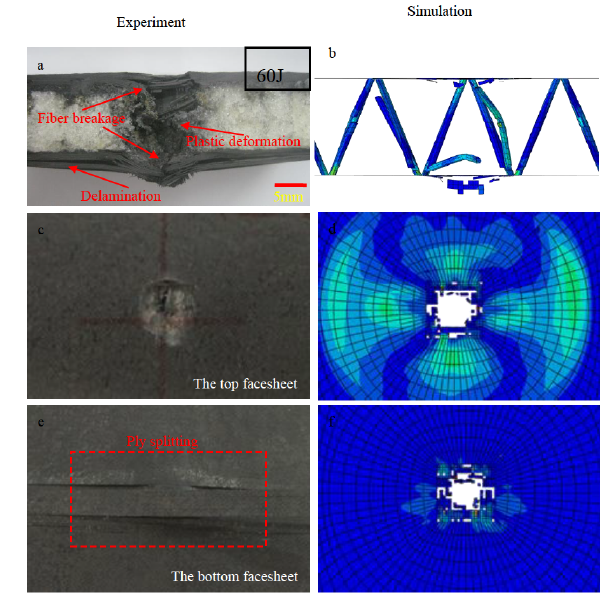
Figure 16: Impact damage of experimental and FEM simulation of foam sandwich composite stitched by 1mm diament strut at the impact energy of